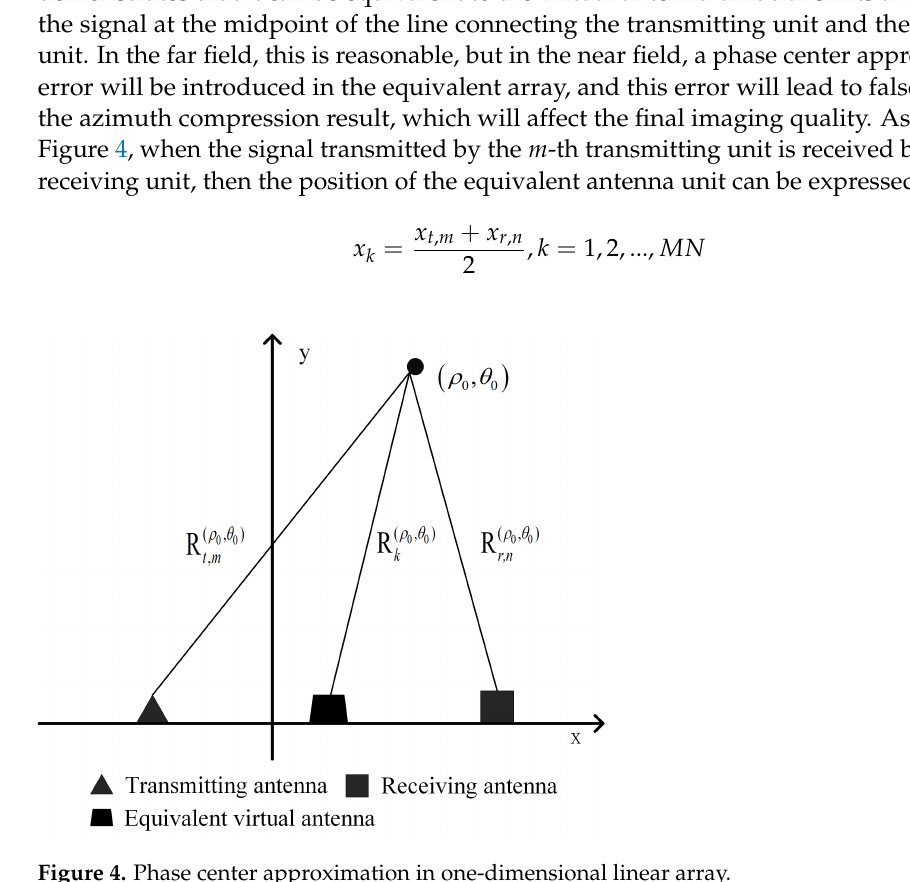
Figure 4. Phase center approximation in one-dimensional linear